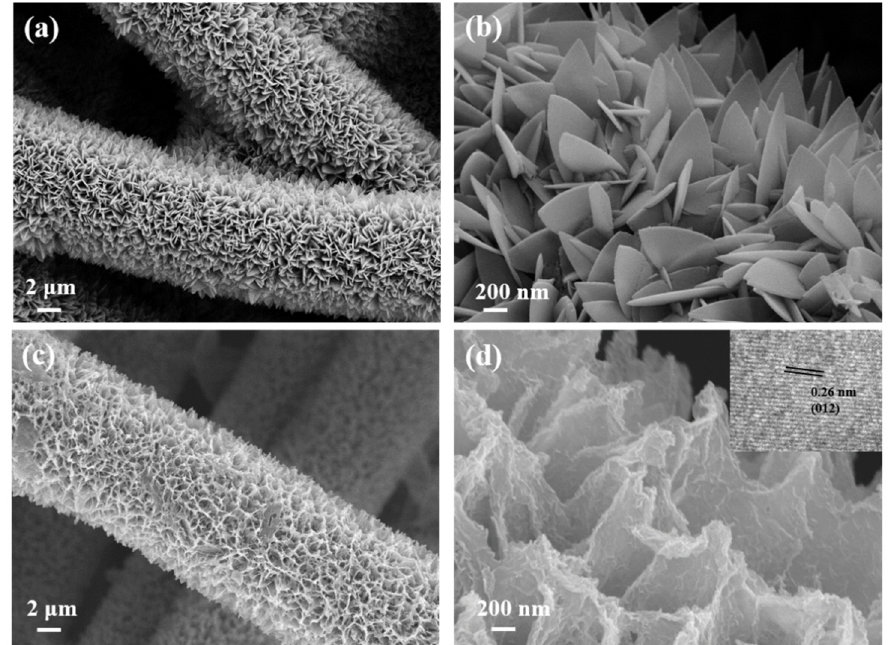
Figure 2. SEM images of ( a , b ) Co ‐ ZIF@CC and ( c , d ) CoFe ‐ LDH@Co ‐ ZIF@CC (inset: the lattice